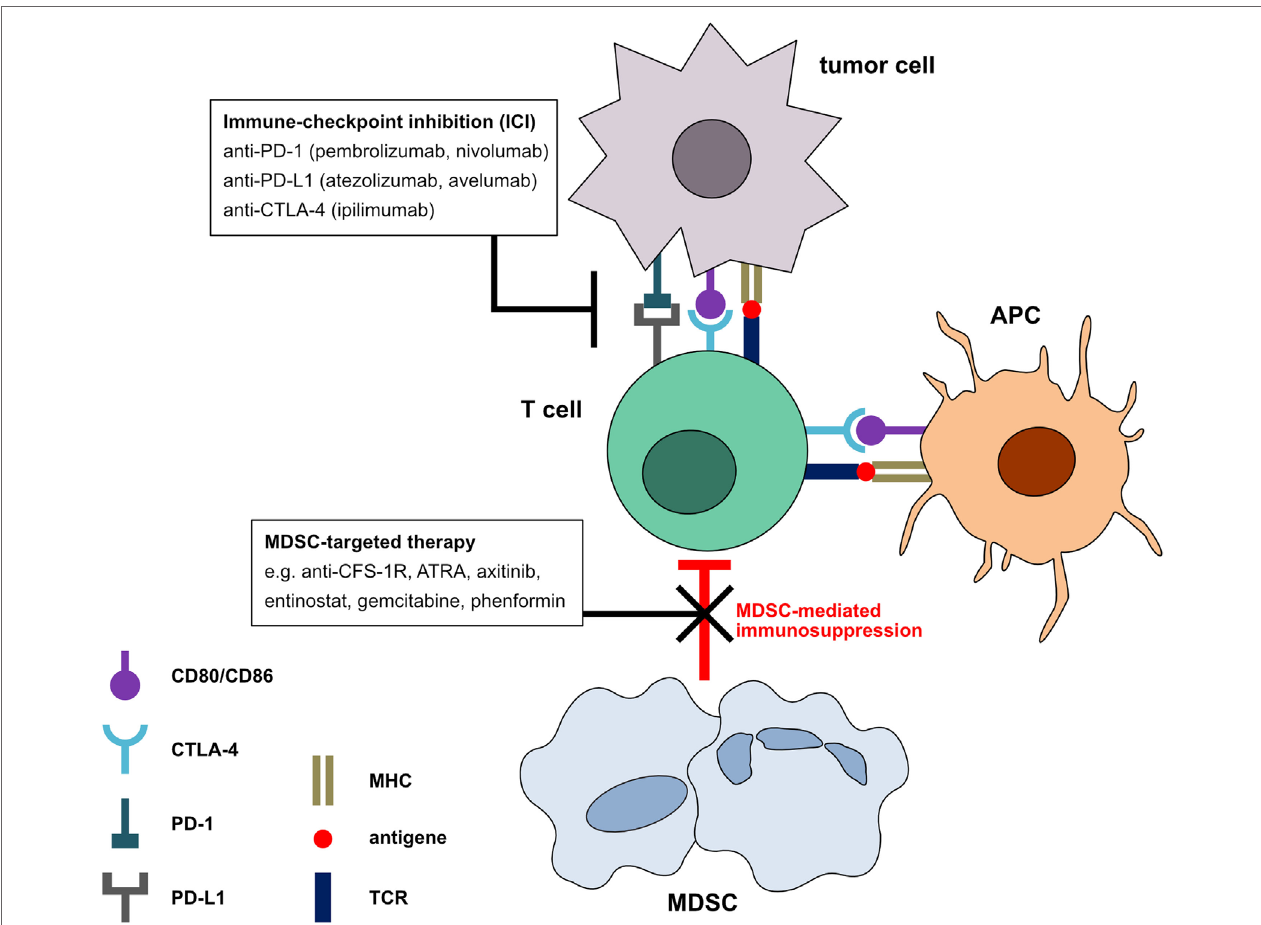
FiGURe 1 | Mechanism of immune checkpoint inhibitors (ICI) in combination with myeloid-derived suppressor cell (MDSC) neutralization. In the tumor microenvironment, tumor and antigen-presenting cells express the ligands for programmed cell death protein 1 and cytotoxic T-lymphocyte-associated protein 4 receptors on T cells. Signals transmitted via these receptors induce a T cell arrest and the termination of the anti-tumor immune response. Blockade of these negative checkpoint molecules can restore the anti-tumor activity of T cells. However, MDSC can induce T cell inhibition by mechanisms different from negative checkpoint molecules. The combination of MDSC inhibition with ICI could further increase T cell-mediated anti-tumor immune responses and the clinical outcome of cancer